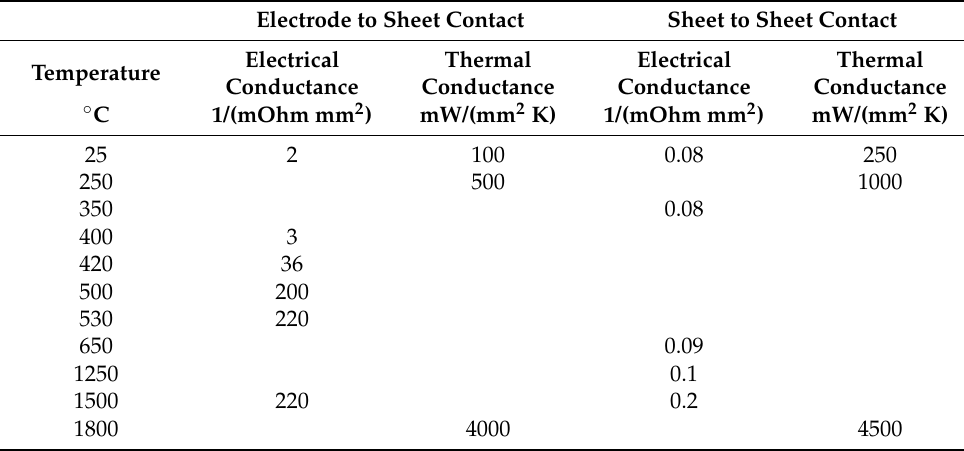
Table 3. Contact properties between electrode/sheet and sheet/sheet.